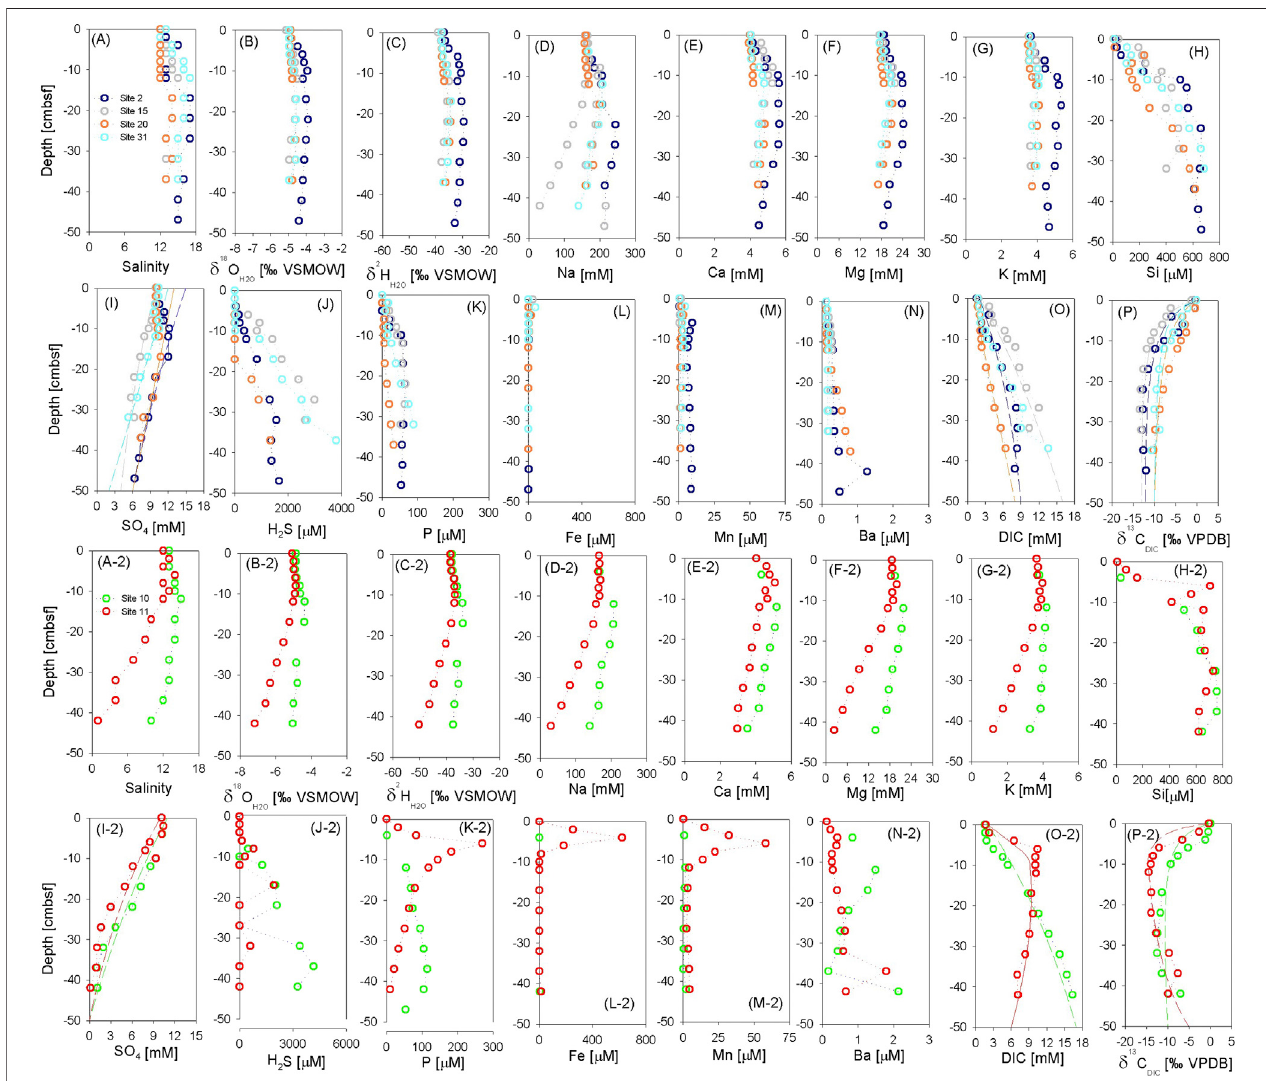
FIGURE6| Porewaterpro fi les insedimentcoresfrom WBshowingsalinity (A) , 18 O H2O (B) , 2 H H2O (C) ,anddifferentdissolved components Na (D) ,Ca (E) ,Mg (F) , K (G) ,Si (H) ,SO 4 (I) ,H 2 S (J) ,P (K) ,Fe (L) ,Mn (M) , Ba (N) , DIC (O) , 13 C DIC (P) ,ofsites2,15, 20,and 31.Thesites impacted byfreshening at deptharepresented inthe panels: salinity (A-2) , 18 O H2O (B-2) , 2 H H2O (C-2) , and different dissolved components Na (D-2) , Ca (E-2) , Mg (F-2) , K (G-2) , Si (H-2) , SO 4 (I-2) , H 2 S (J-2) , P (K-2) , Fe (L-2) , Mn (M-2) , Ba (N-2) , DIC (O-2) , 13 C DIC (P-2) . The additional dashed lines in the panels I, I-2, O, O-2, P, P-2 are the diagenetic modeling results.